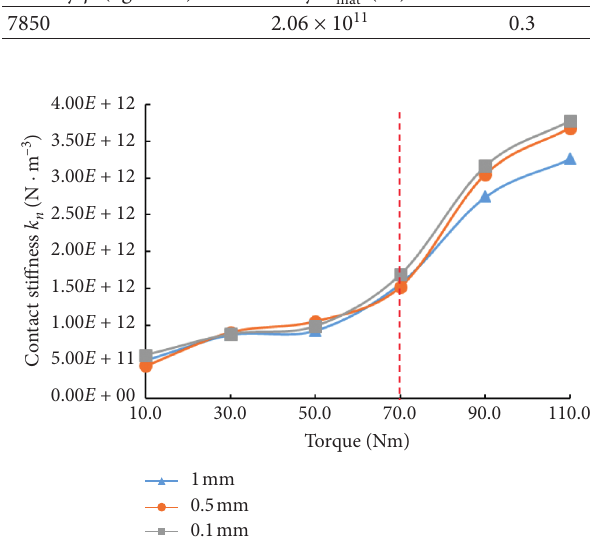
Figure 11: Updated stiffness using thin-layer element of three different